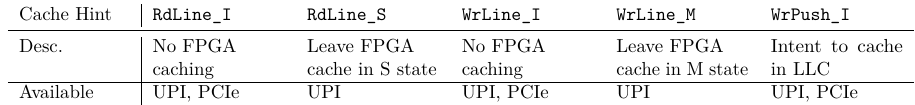
Table 1: Overview of the caching hints configurable over CCI-P on an integrated FPGA. *_I hints invalidate a cache line in the local cache. Reading with RdLine_S stores the cache line in the shared state. Writing with WrLine_M caches the line modified